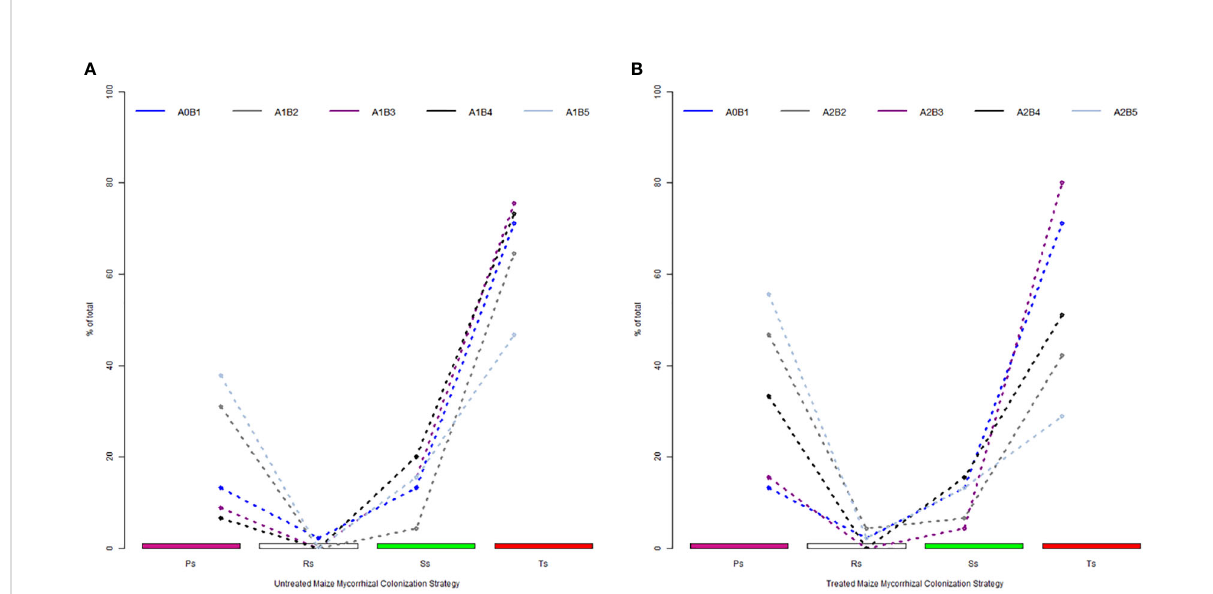
FIGURE 2 Speci fi c phenophase colonization strategy shaped by the effect of biostimulator application: (A) untreated plants and (B) treated plants. Legend: A0-B1, control variant (native mycorrhizal pro fi le) in phenophase 2 – 4 leaves; A1, untreated plants; A2, treated plants; B2, phenophase of 6 formed leaves; B3, phenophase of 8 – 10 formed leaves; B4, cob formation phenophase; B5, phenophase corresponding to physiological maturity; Ps, proliferation strategy; Rs, resistance conditions strategy; Ss, storage strategy; Ts, transfer